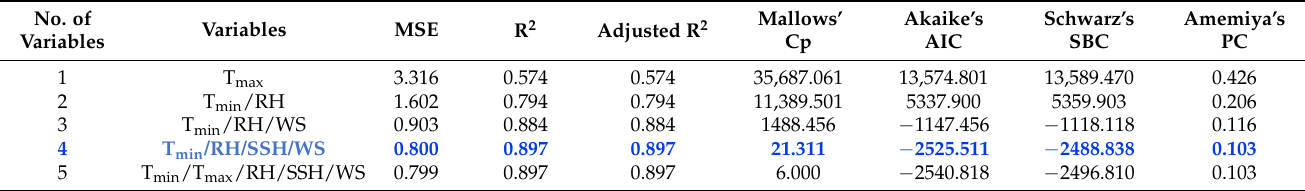
Table 4. The best subset regression analysis for determining the best input combinations at the Ludhiana station. No. of